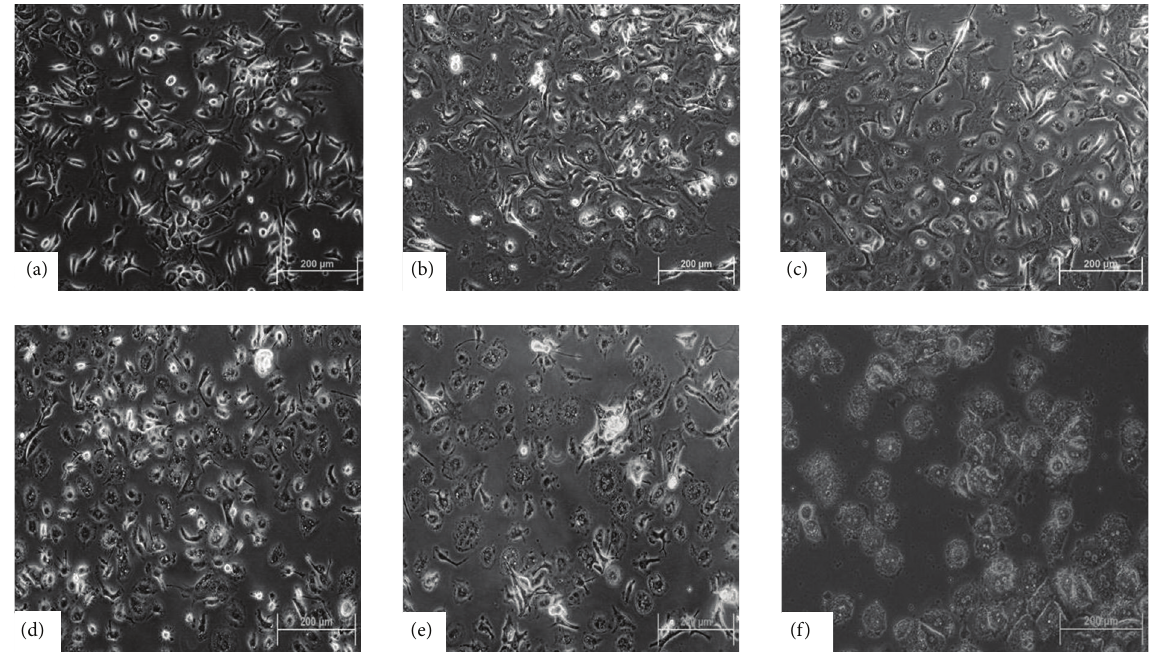
Figure 1: Morphological changes in cytokines pretreated MSCs: (a) MSCs as negative control; (b, c, d, and e) 7-, 15-, 21-, and 28-day cytokines pretreated MSCs; (f) mature hepatocytes as positive control (200x, scale bar ∼ 200 𝜇 m). fibroblastic to hepatocyte-like polygonal shape from day 0 to day 28 of treatment (Figure